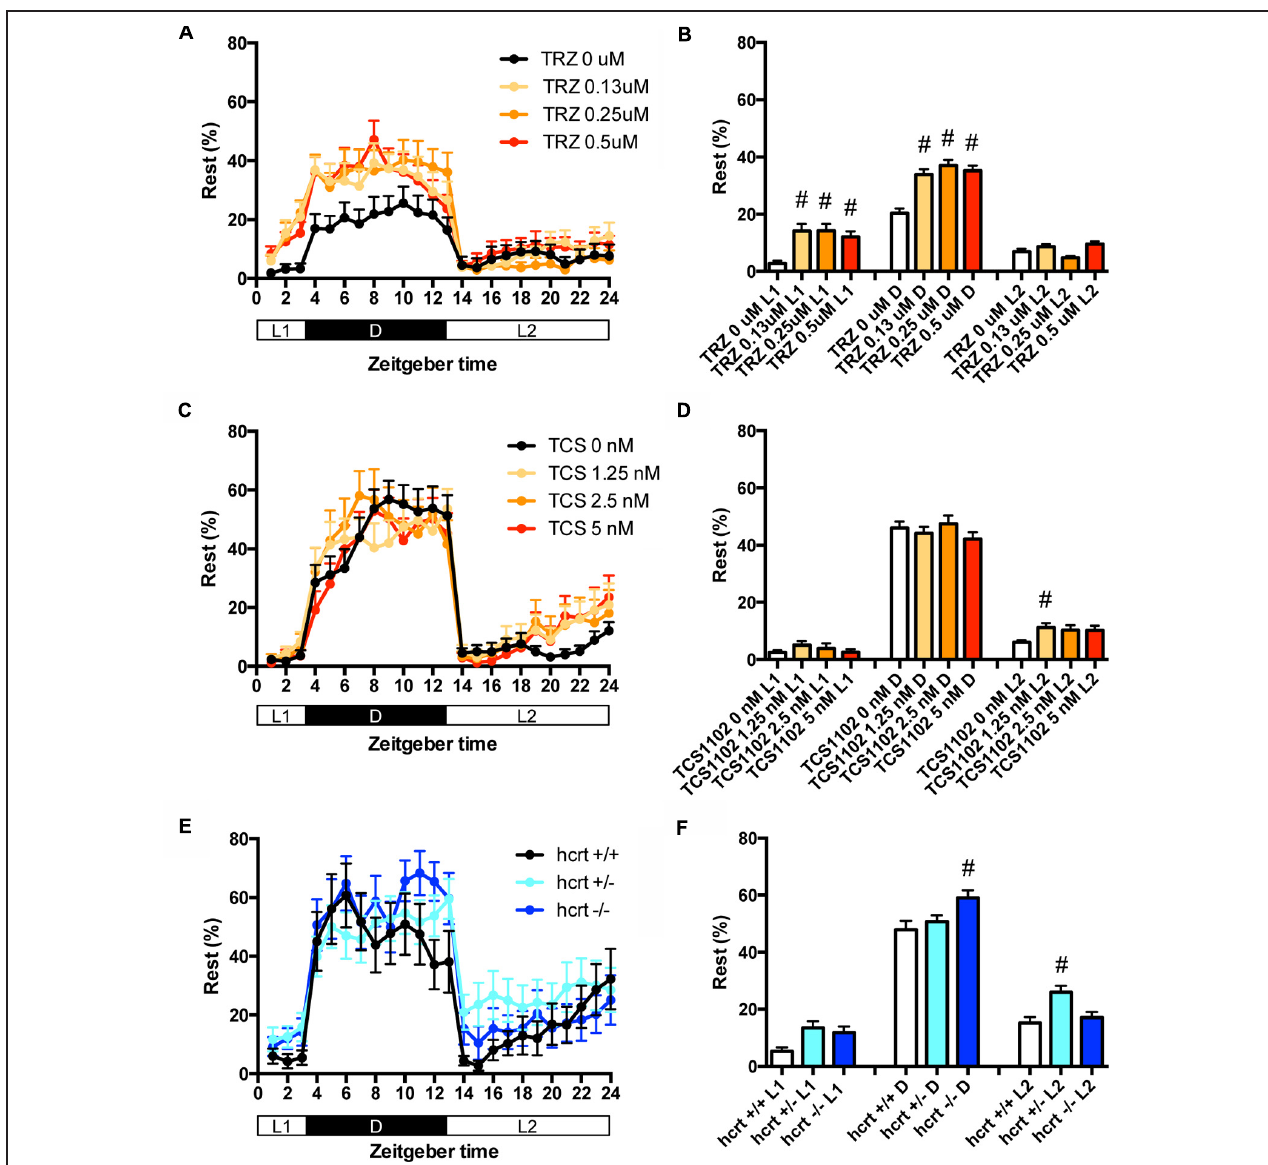
FIGURE 4 | Effects of triazolam, TCS1102, and hcrt knockout on the rest state of zebrafish. The rest state of zebrafish treated with triazolam (A) , TCS1102 (C) , and hcrt knockout (E) from 9 to 10 dpf are shown as percentage of total behavior. The rest state of zebrafish treated with triazolam (B) , TCS1102 (D) , and hcrt knockout (F) from 9 to 10 dpf are shown as percentage in L1, D, and L2. The data are represented as means with the standard error of mean. # p < 0.05 vs.